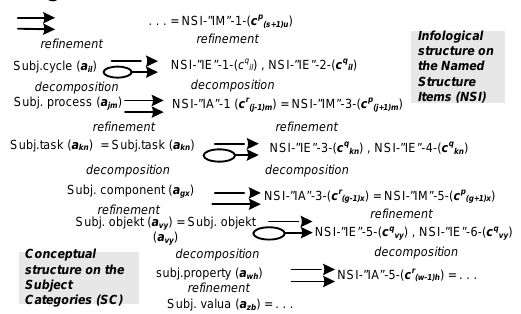
Fig. 3. The pattern of mapping conceptual structures on SCs to infological structures on